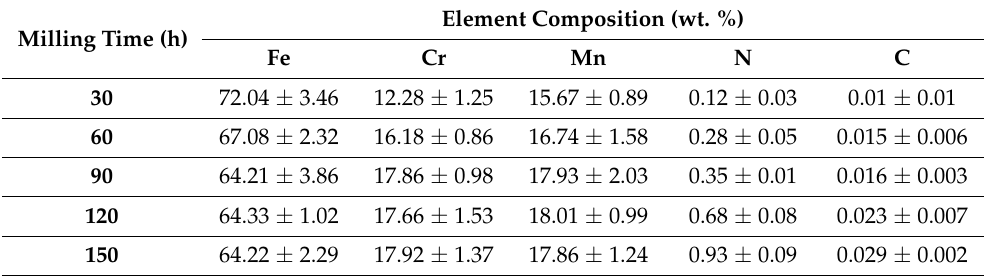
Table 2. SEM-EDS analysis of the iron, chromium, and manganese concentrations in the MA powders at different milling